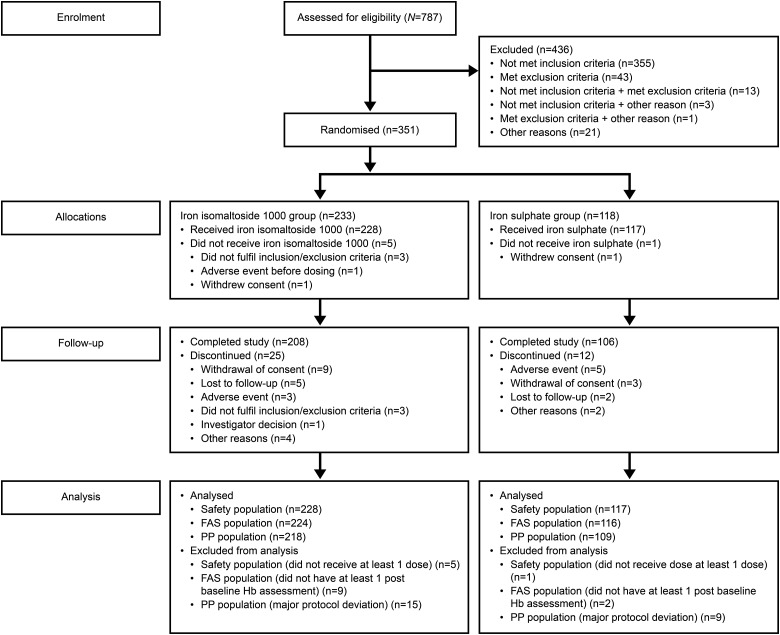
Patient disposition.